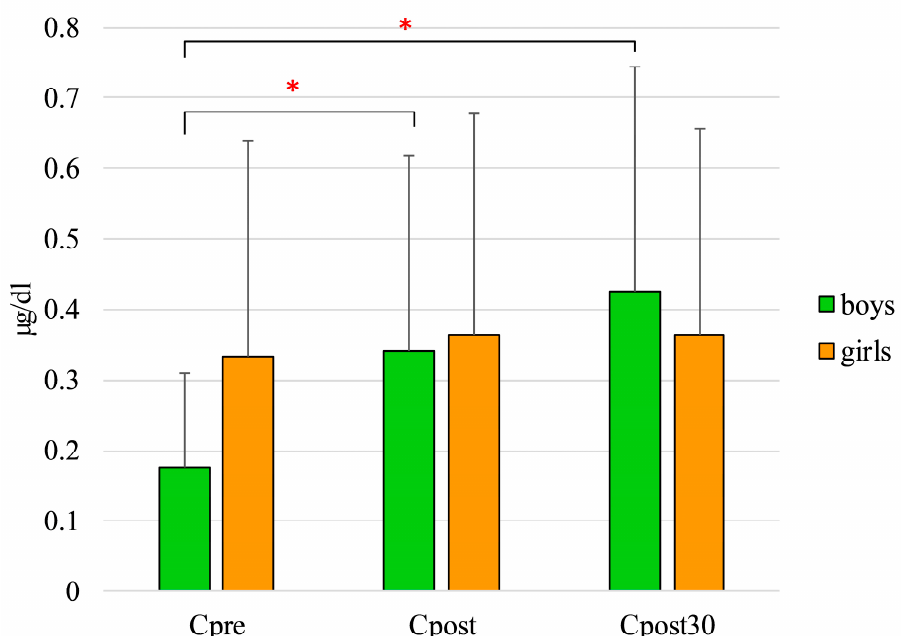
Figure 1. C level changes of boys and girls (* p < 0.05). Cpre: cortisol levels before the field test; Cpost: cortisol levels after the field test; Cpost30: cortisol levels 30 min after the field test. The maximal heart rate during the FT did not differ between boys and girls (190.278 ± 7.537 vs. 190.917 ± 9.040 beat/min); however, the HRR60 was higher in girls (29.22 ± 7.37 vs. 40.583 ± 14.501 beat/min; p = 0.0084), whereas the HRmax/HRR60 ratio was higher in boys (6.861 ± 1.542 vs. 5.388 ± 2.314; p = 0.045) (Figure 2).